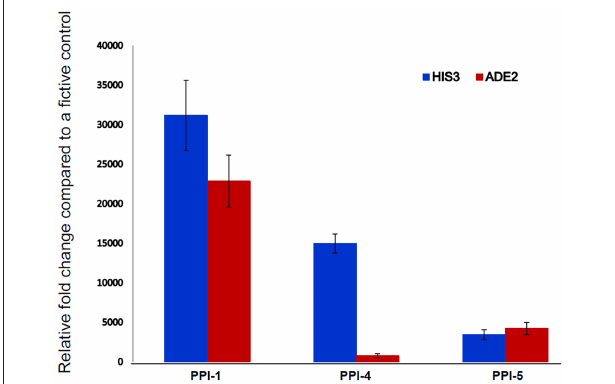
FIGURE 4 | Confirmation of PPI strength using qRT-PCR. The qRT-PCR analysis quantified the expression of two reporter genes HIS3 and ADE2 for determining the strength of PPI for the selected yeast colonies (PPI-1, PPI-4, and PPI-5). These genes are under the control of Gal4-responsive promoters. The interaction between the bait and prey proteins allow the Gal4-responsive HIS3 and ADE2 genes to biosynthesis histidine and adenine for cell